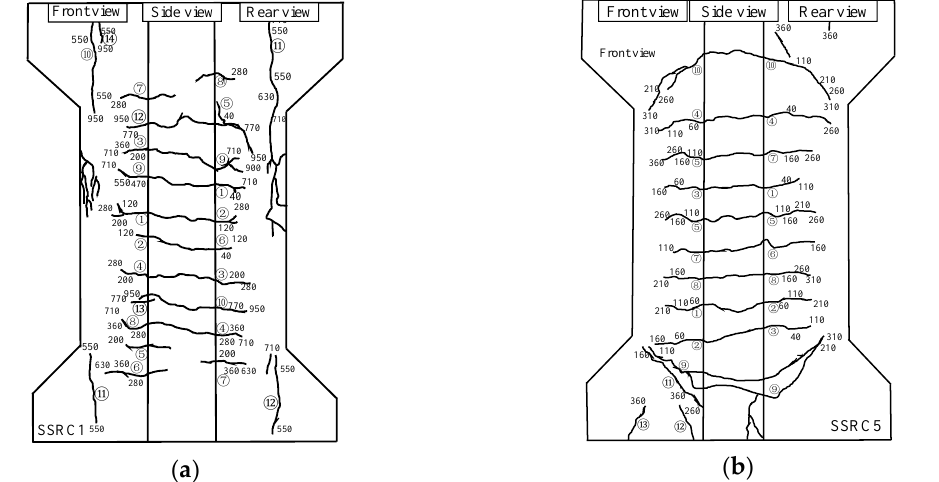
Figure 4. Typical crack patterns: ( a ) small eccentric and ( b ) large eccentric.